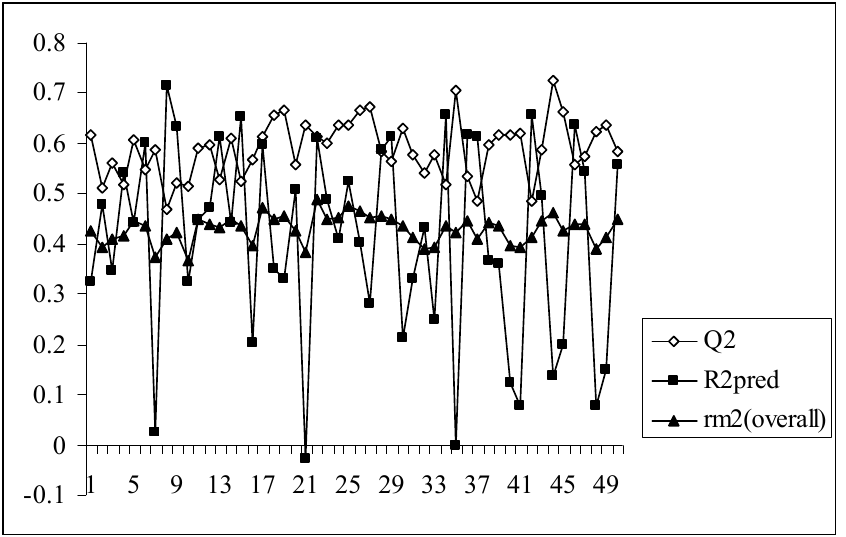
and r m2 values of 50 models (data set (overall) pred